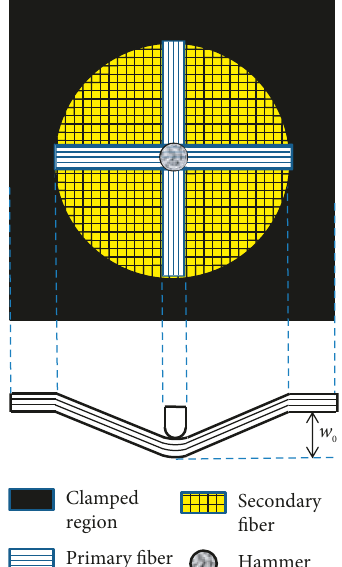
Figure 14: Subarea of the BFRP plate under